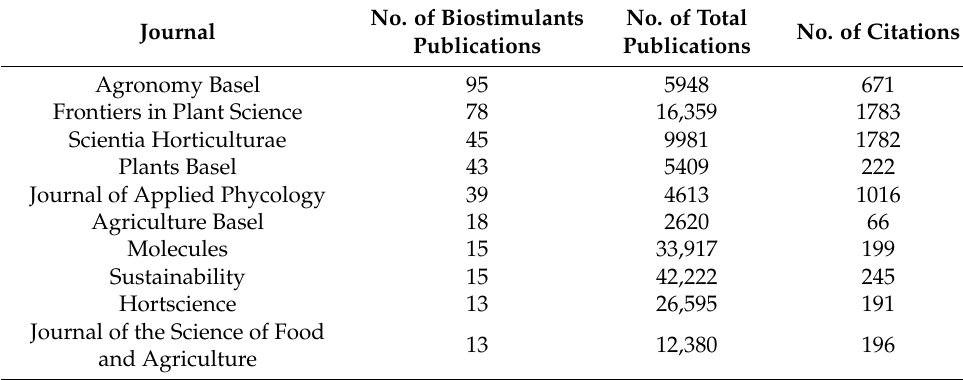
Table 2. Biostimulant publications’ top 10 most productive